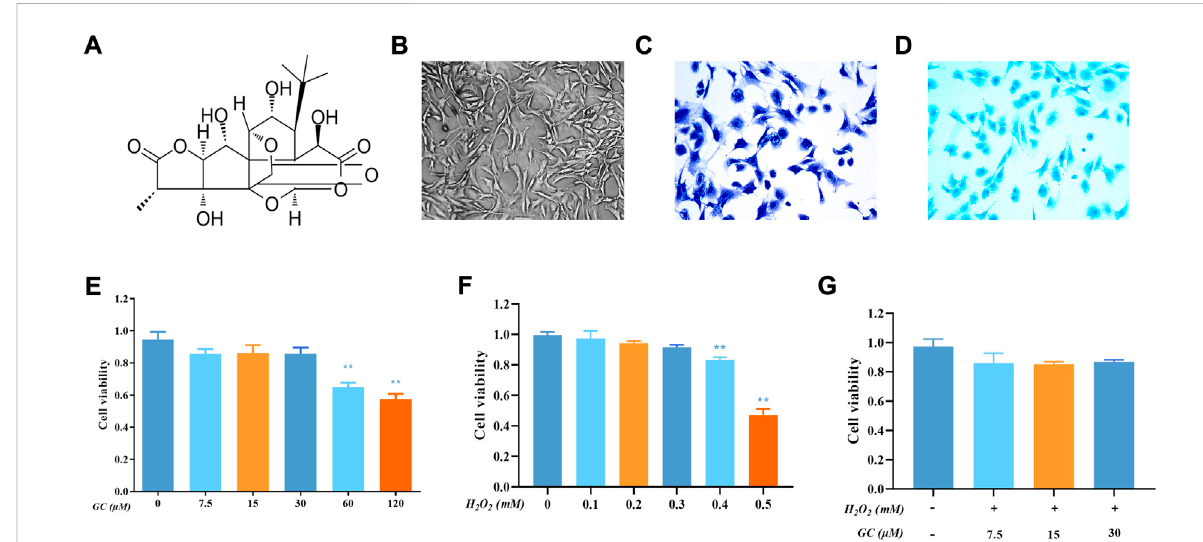
FIGURE 1 Effect of Ginkgolide C (GC) on chondrocyte viability with or without H 2 O 2 . (A) Chemical structure of the GC. (B) Representative image of second-generation chondrocytes rat chondrocyte morphology. (C) Representative image of Toluidine blue staining. (D) Representative image of Allisonbluestaining. (E) CellCountingKit-8(CCK-8)detectedthecellviabilityofchondrocyteswithdifferentconcentrationsofGCfor24 h (F) CCK- 8 results for chondrocytes treated with different concentrations of hydrogen peroxide (H 2 O 2 ) for 24 h (G) CCK-8 results for GC-treated chondrocytes stimulated with H 2 O 2 . All data are presented as mean ± SD (n = 3). ** p < 0.01 relative to the control